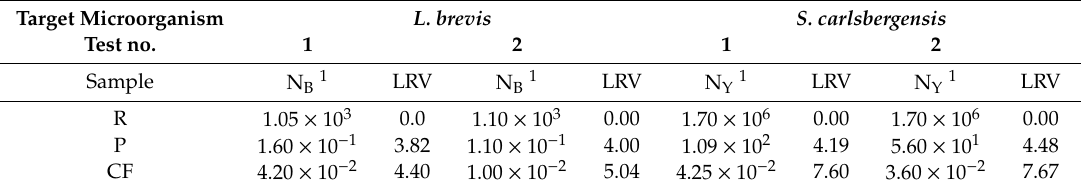
Table 4. Main results of the microbiological analyses: number of bacterial (N B ) or yeast (N Y ) cells in samples aseptically collected at the retentate (R), permeate (P), and cartridge filter (CF) exit ports of the CFMF bench-top plant used in this